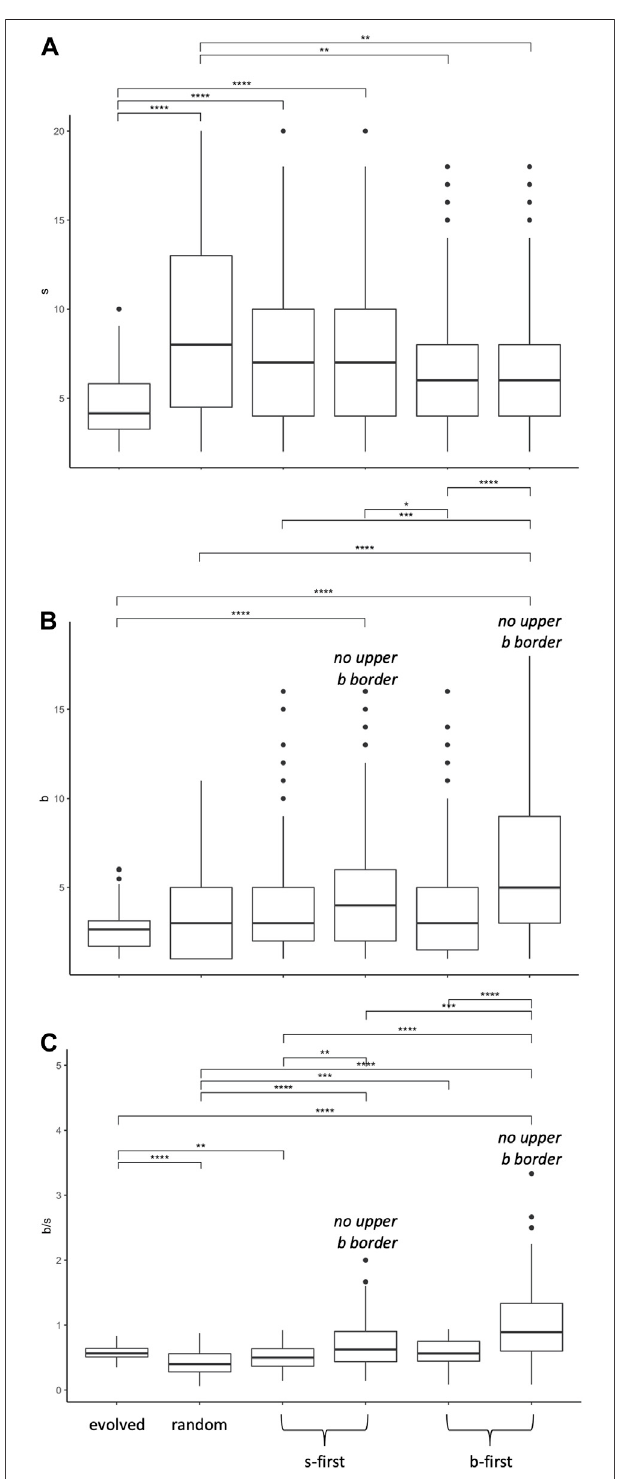
FIGURE12| Morphospacewalkanalysis:evolutionin s - b morphospace isnotarandomwalk.The fi nalpositionsofthepopulation(evolved,generation 100) and random walks (step 100) are compared in 99 different instances (99 evolutionary runs from 11 mutation levels and nine populations